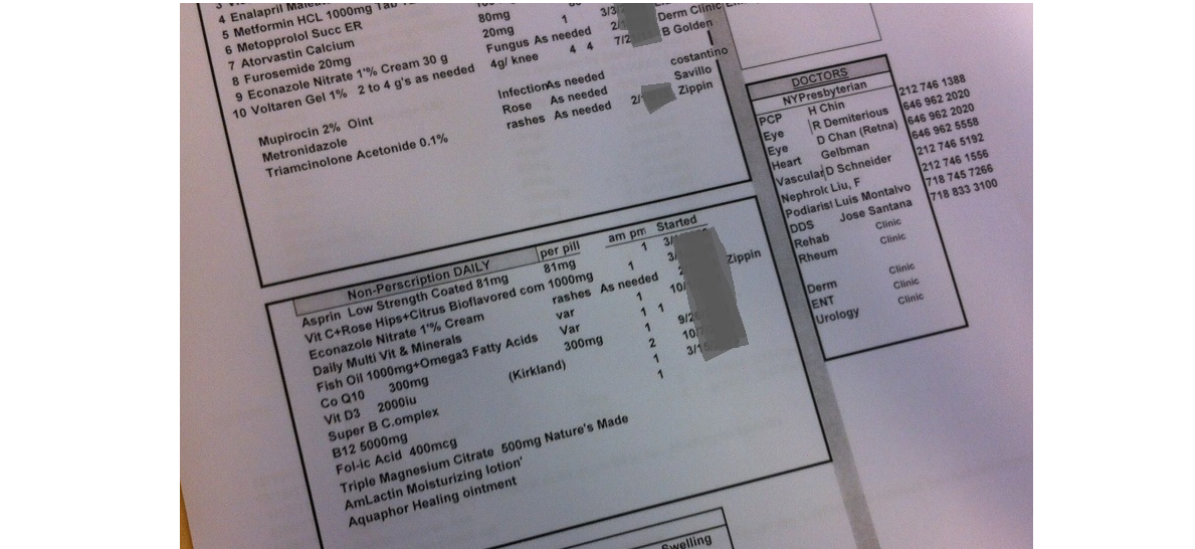
Figure 1. Portion of a 3-page personally tracked record by an individual with multiple chronic diseases. This patient regularly updated the Excel spreadsheet with medications, dates of medical appointments and events, contact information, etc. Dates have been masked.